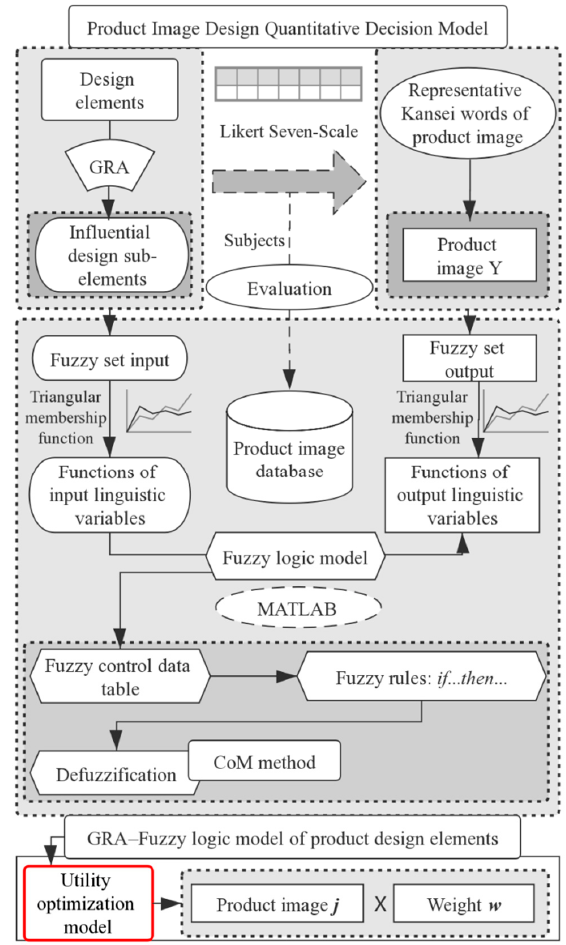
Figure 6. The quantitative decision model of product image design.